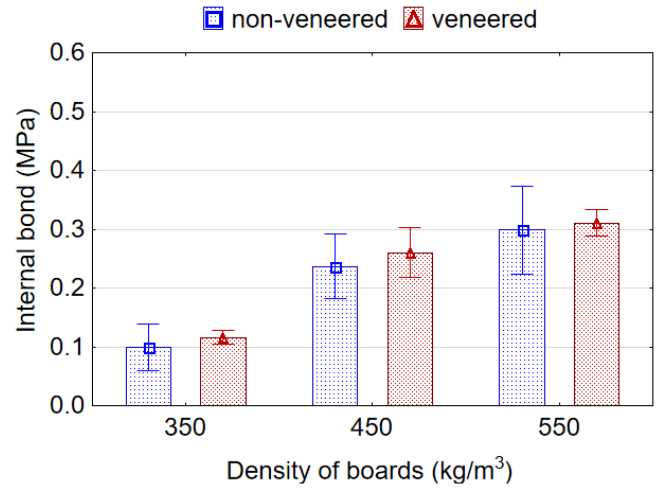
Figure 10. Internal bond strength of non-veneered and veneered lightweight particleboards.